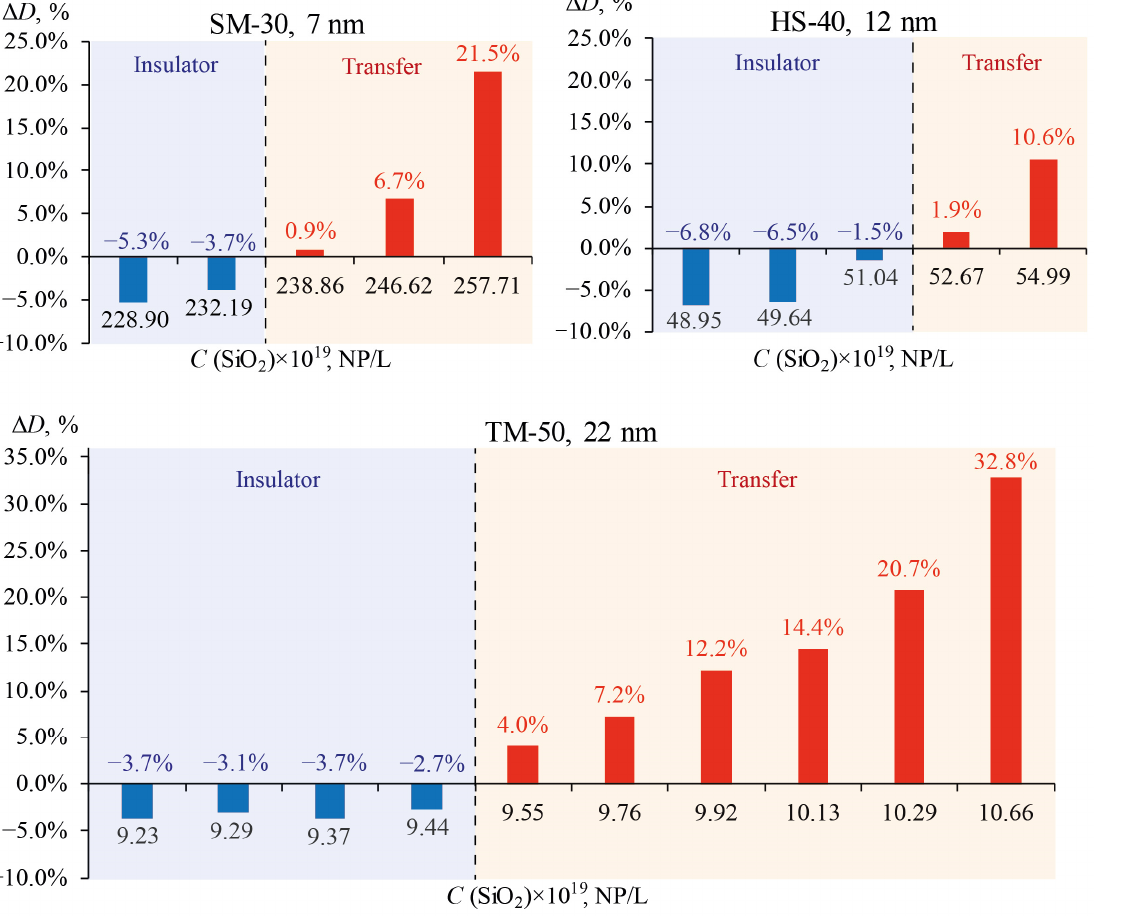
Figure 11. Increase in thermal conductivity for SiO 2 dispersions of various Ludox series in comparison with pure water. A decrease is denoted with negative values (blue color), and an increase is denoted with positive values (red color).